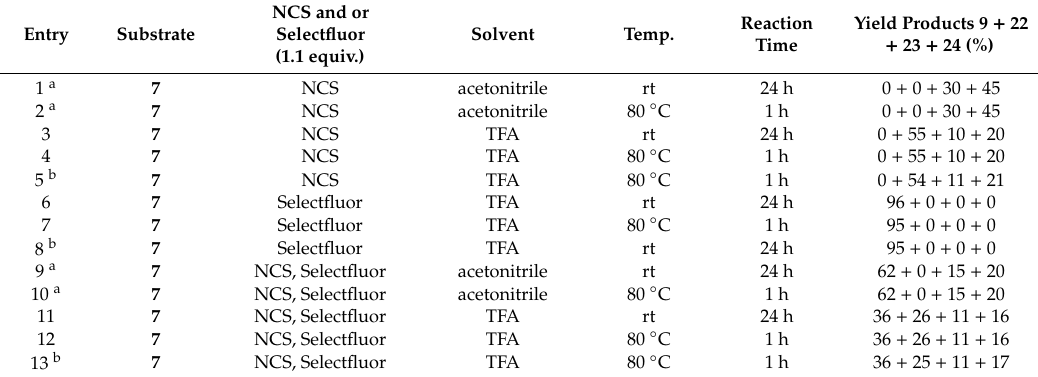
Table 2. E ff ect of the reaction conditions on the fluorination and / or chlorination of compound 7 . NCS and or Entry Substrate Selectfluor Solvent (1.1 equiv.)